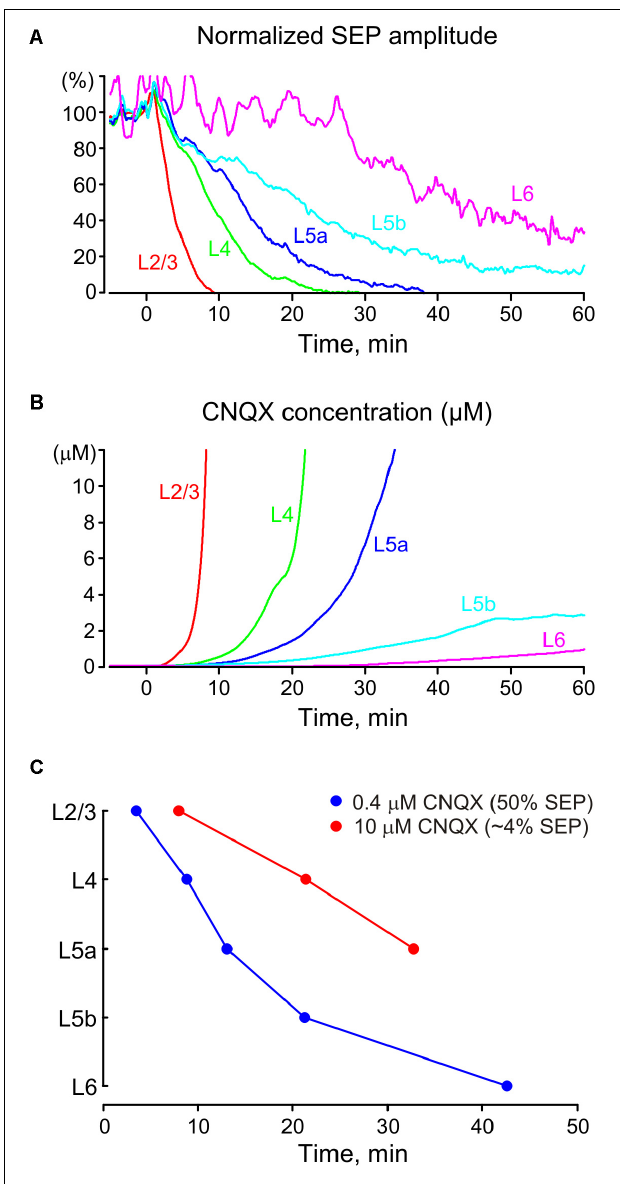
FIGURE 7 | Pharmacokinetics of CNQX and dAPV after epipial application. (A) Development of the inhibitory effect of CNQX and dAPV on SEP amplitude across cortical layers over 1 h of application (averaged data from 11 animals). (B) Estimation of CNQX concentration dynamics in different cortical layers after epipial drug application. Instant values of CNQX concentration were calculated based on the concentration dependence of CNQX effect on the fast EP SCs with a K d of 0.4 µ M and Hill coefficient of 1 (Honore et al., 1988; Llano et al., 1991). (C) The time points where epipially applied CNQX (170–500 µ M) attains K d values of 0.4 and 10 µ M at different depths of the cortical